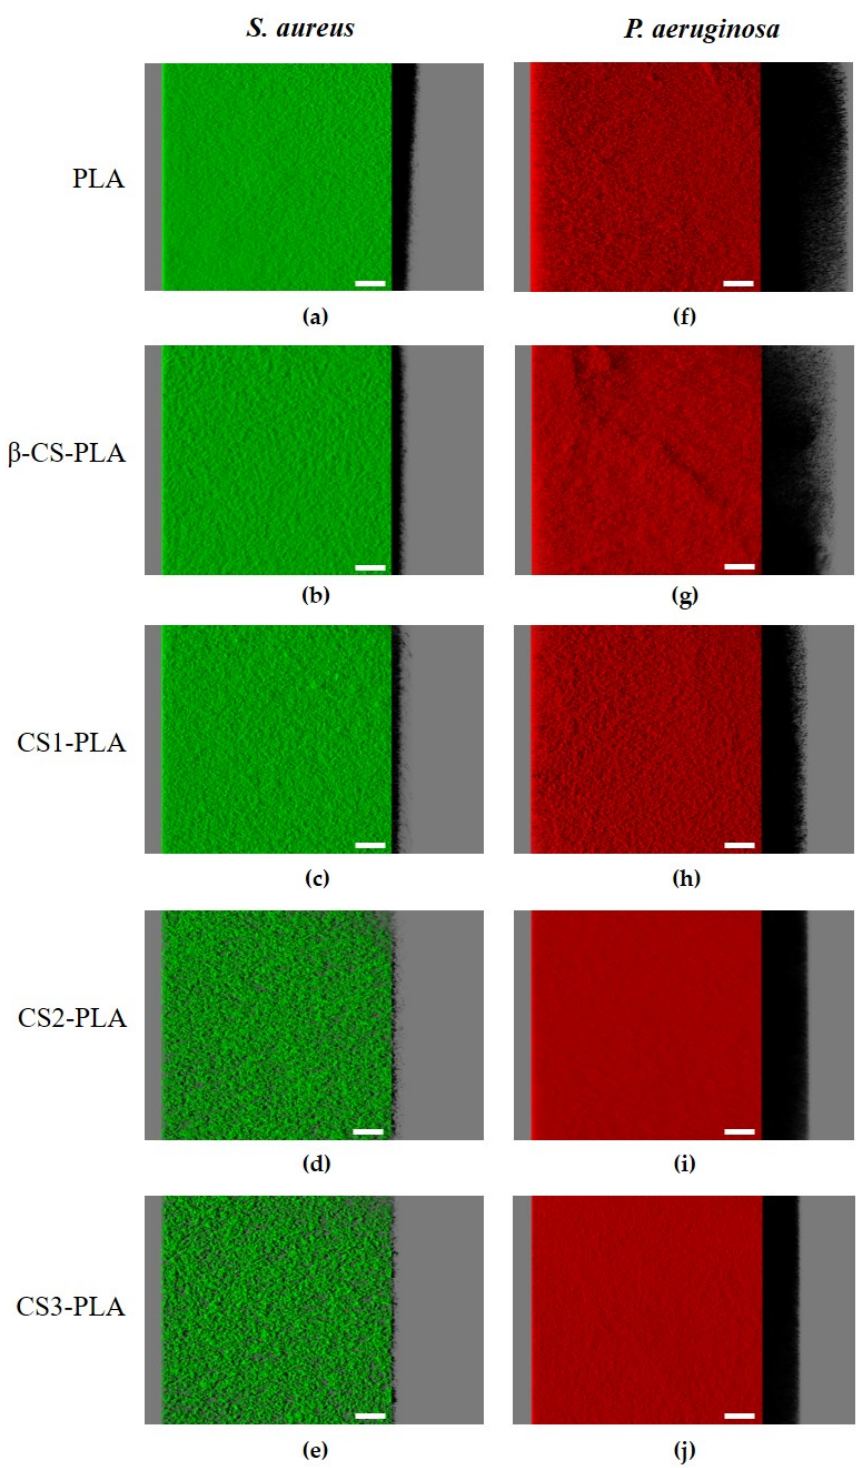
Figure 3. Single-species biofilms of ( a – e ) S. aureus and ( f – j ) P. aeruginosa developed on PLA and CS-coated PLA surfaces. These representative images were obtained from confocal z -stacks using IMARIS software and present an aerial, three-dimensional (3D) view of the biofilms. The shadow on the right represents the vertical projection of the biofilm. Scale bars are 50 μ m.